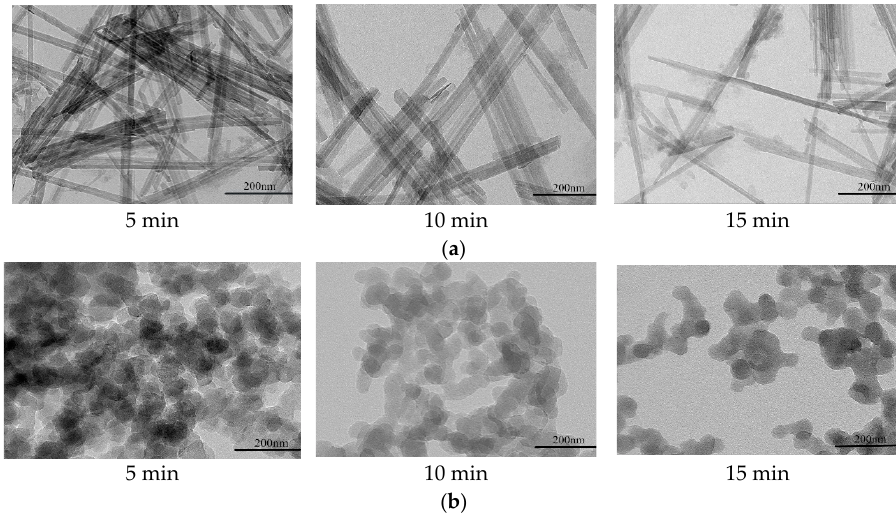
Figure 5. TEM micrograph of ultrasonically dispersed nanoclay.( a ) NMA-2;( b ) NMK-5. Table 5. The gray histogram of the nanoclay suspension. Table 5. The gray histogram of the nanoclay suspension. Table 5. The gray histogram of the nanoclay suspension. The nanoclay(NMA-2, NMK-3)suspension gray histogram is shown in Table 5. Table 5. The gray histogram of the nanoclay suspension. When the initial dispersion is completed (0h), the range of gray values in the gray histo- gram of NMA and NMK suspensions is small, showing a single peak and peak concen- tration, indicating that the nanoclay suspension after ultrasonic dispersion is more uni- form. With the increase in settlement time, the NMA and NMK suspensions gradually settle. The range of gray values in the gray histogram increases, the probability of gray value decreases, and the gray value increases slightly, indicating that the gray histogram of nanoclay suspension can reflect the settlement process of the suspensions. The super- natant area increases with settlement time, which characterizes the settlement law of nanoclay suspensions. Therefore, the sedimentation rate of nanoclay suspensions is de- termined by the particle size of the clay particles after the dispersion of the nanoclay suspension, rather than the initial particle size of the nanoclay particles. The analysis of the NMA and NMK suspension gray histogram found that the NMA and NMK suspension gray histogram function obeys normal distribution. The suspen- sion gray histogram function is: